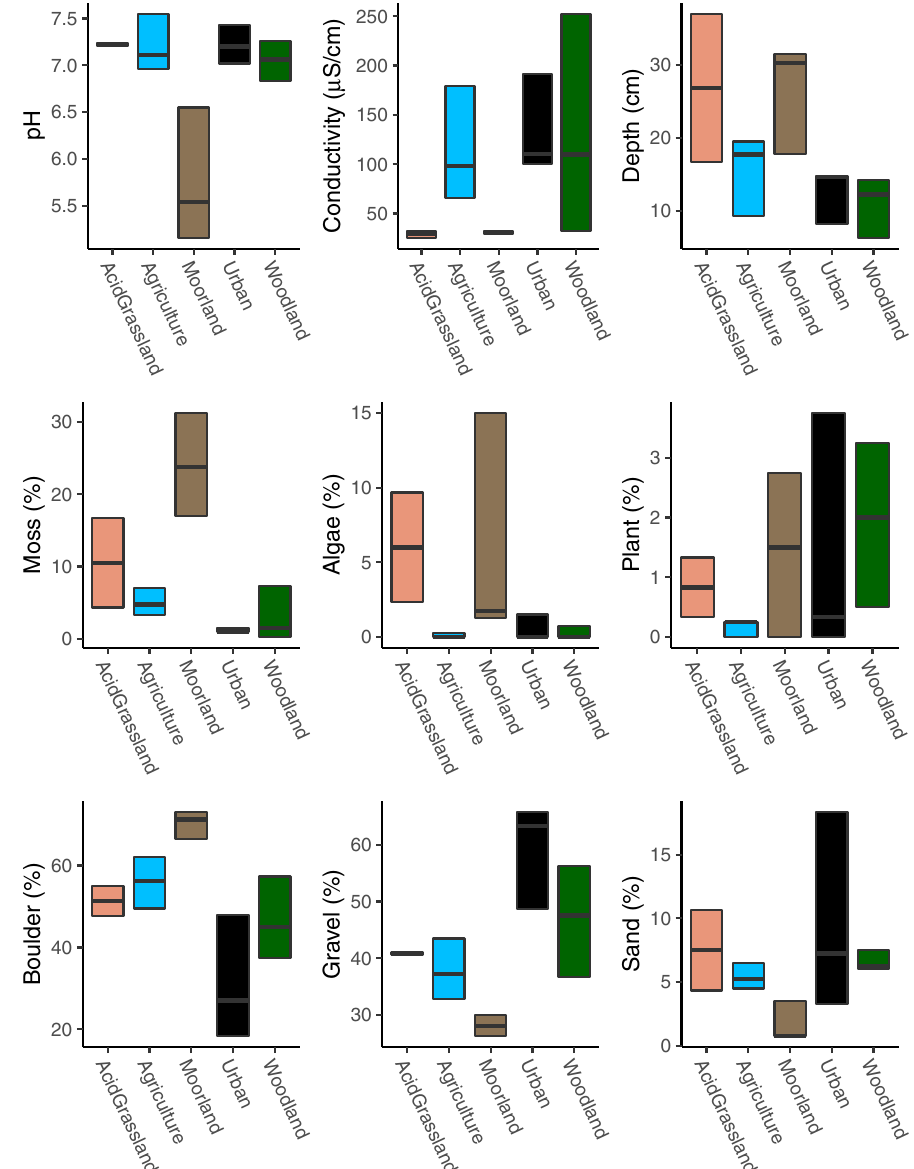
Fig. 2 Environmental variation across landuse types. Box plots for each environmental variable (y-axis) sampled in the study, as a single panel across sites ( N = 14). The colors in each plot match the colors in Fig. 1 for each landuse type (x-axis). The range of the boxplots extends to the minimum and maximum of their corresponding